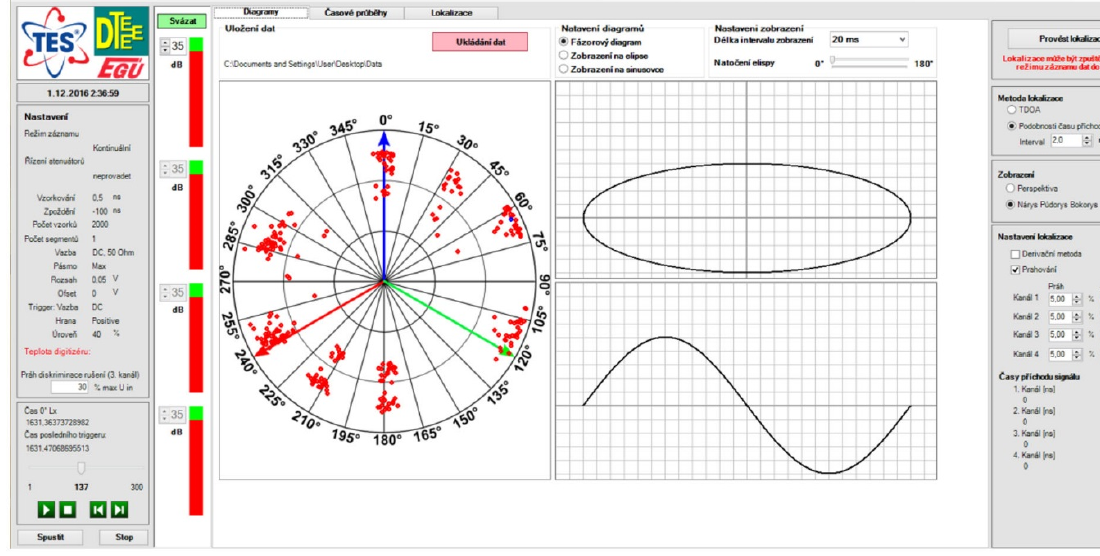
Figure 9. The general window of the PD diagnostic software, with impulse signal detection events (the red dots) in the magnitude-phase diagram.